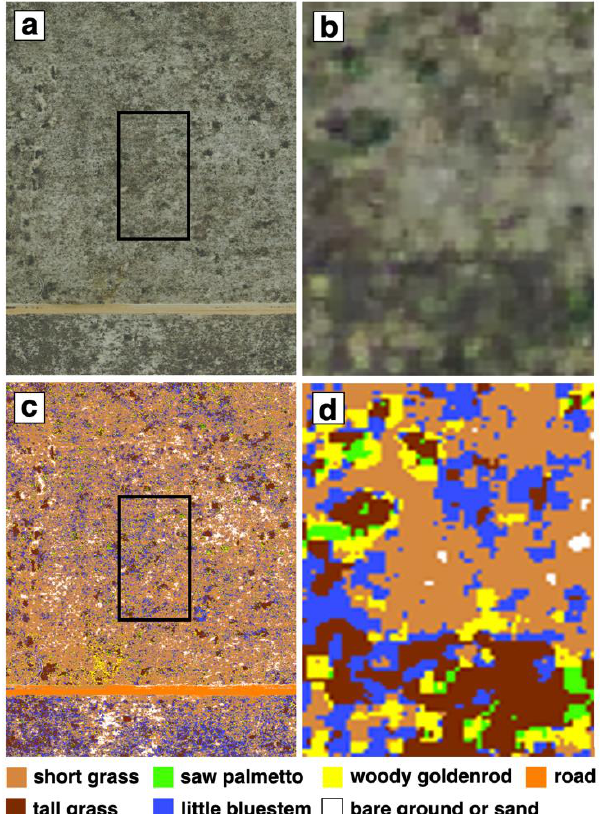
Figure 1. Fuel class verification. ( a ) High-resolution (0.15 m) raw visible spectrum imagery of the landscape within the FIRETEC computational domain surrounding S5 (400 m by 600 m), with S5 boundary shown in black. ( b ) Visible image zoomed (10 m × 15 m) to show detail near the center of S5. ( c , d ) GENIE fuels classifications for the domains shown in ( a , b ), respectively. Image courtesy of Eglin Air Force Base Geointegration Office.